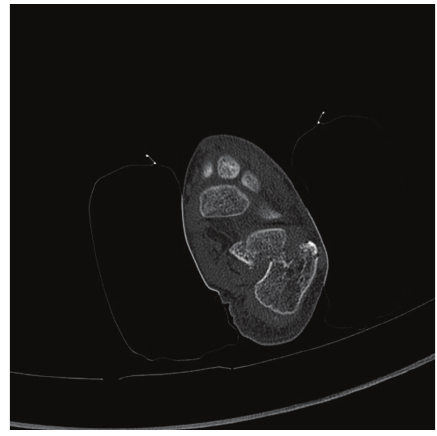
Figure 2: CT scan revealing fracture through body of calcaneus.